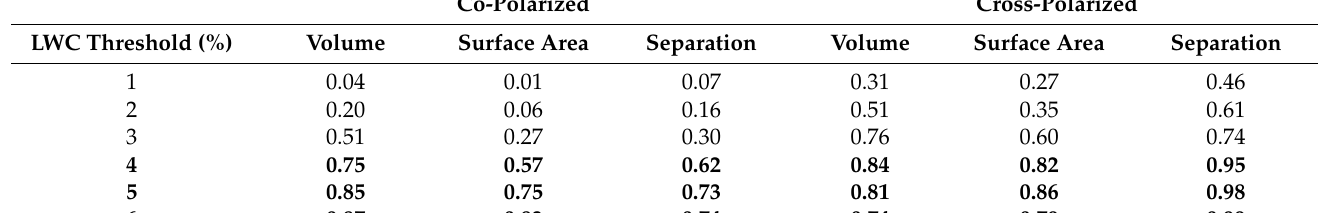
) ) and ( σ vol . Bold values indicated LWC VV VH t = end t = end